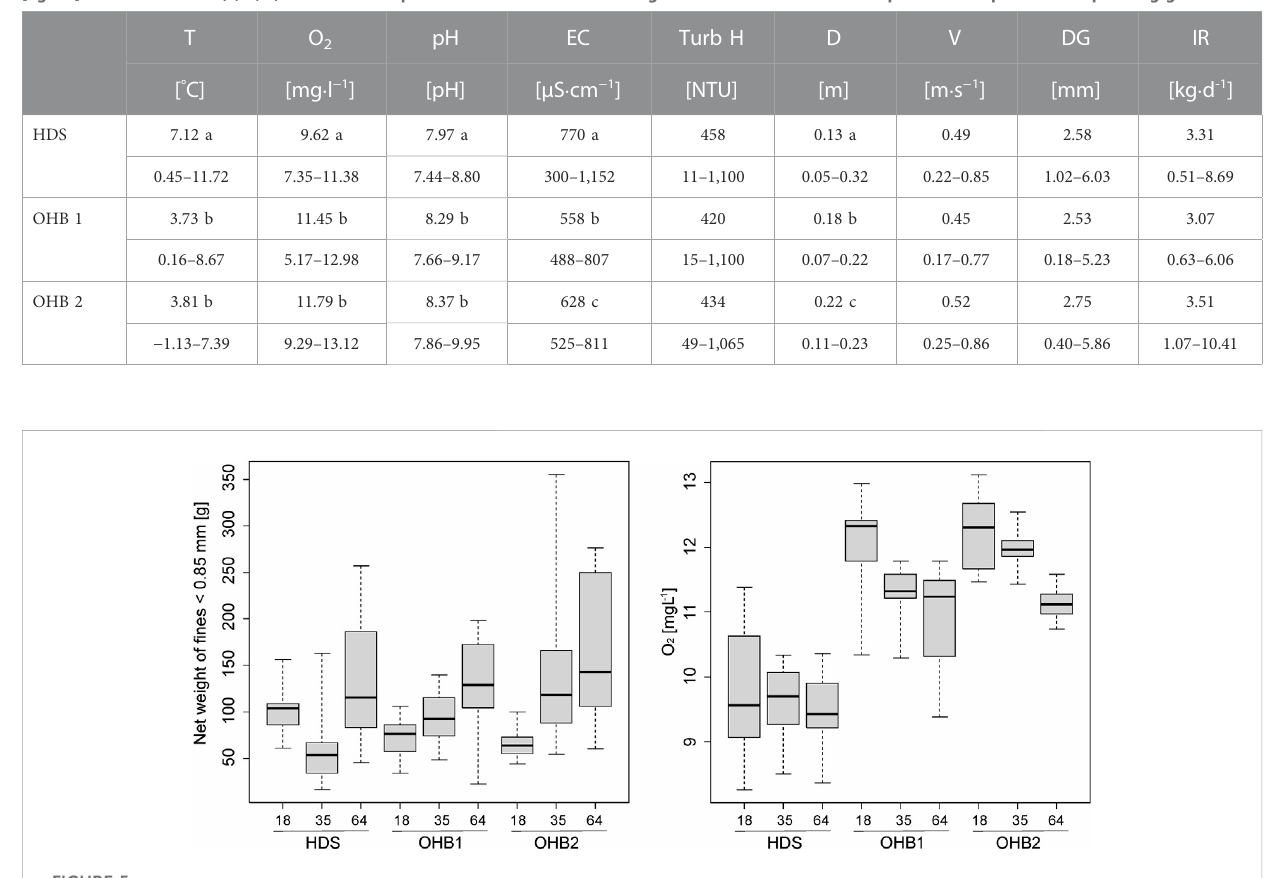
FIGURE 5 Box-whisker-plots (25% quantile, median. 75% quantile, whisker: minimum and maximum values, circles represent outliers) of net fi ne sediment deposition in the HEST [g] and oxygen availability in the interstitial of the HEST [%] at the groundwater-in fl uenced hinterland draining